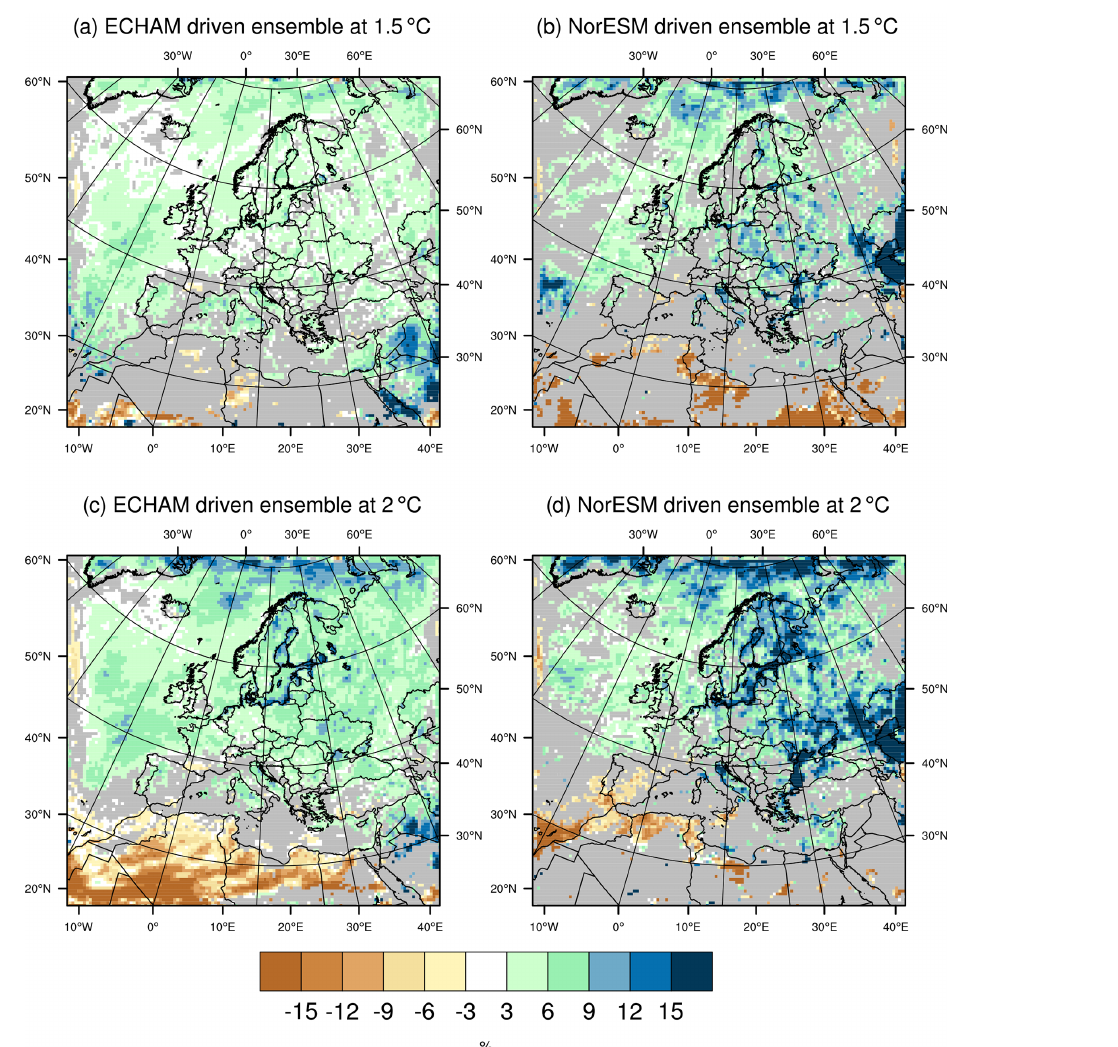
Figure 4. Relative difference of RX5day (in percent) between current and the 1.5 ◦ C period and (a, b) the 2.0 ◦ C period (c, d) for the ECHAM6 with 100 members (a, c) and NorESM with 25 members (b, d) driven REMO simulations. Grey shading shows areas with non- significant changes on the 95% significance